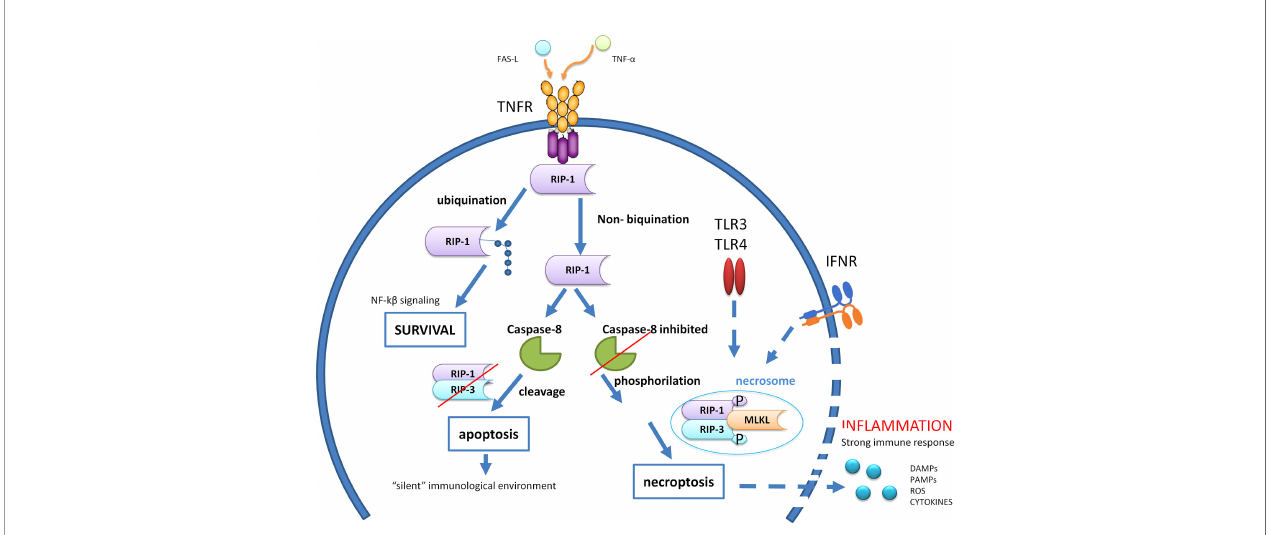
FIGURE 2 | Caspase 8 modulates the crosstalk among cell survival, apoptosis, and necroptosis after engagement of tumor necrosis factor (TNF) death receptors. RIP,receptor-interacting protein; MLKL, Mixed Lineage Kinase Domain Like Pseudokinase; TLR, Toll-like receptor; IFNR, Interferon-gamma receptor; DAMPs, Damage-associated molecular patterns; PAMPs, Pathogen-associated molecular patterns; ROS, Reactive oxygen species; NF-k b , Nuclear factor kappa-light-chain- enhancer of activated B cells; FAS-L, Fas Ligand; TNF- a , Tumor necrosis factor